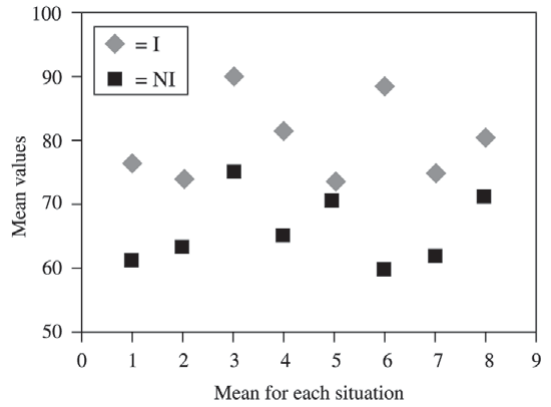
Figure 3. Scatter diagram for the mean values versus mean for each situation.